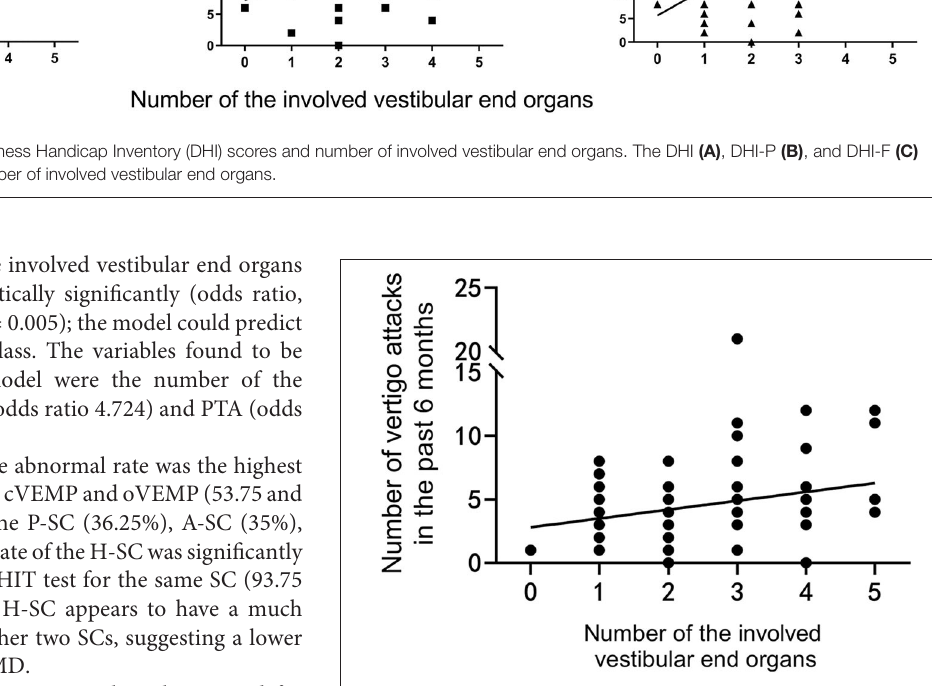
FIGURE 3 | The number of vertigo attacks is positively correlated with the number of involved vestibular end